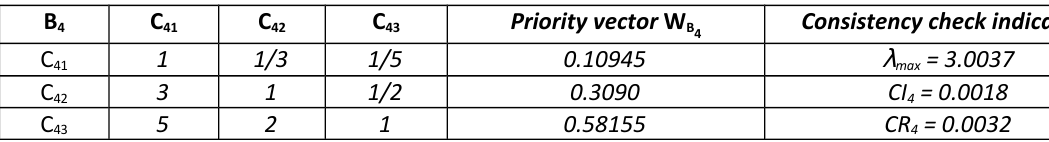
and its consistency check 4